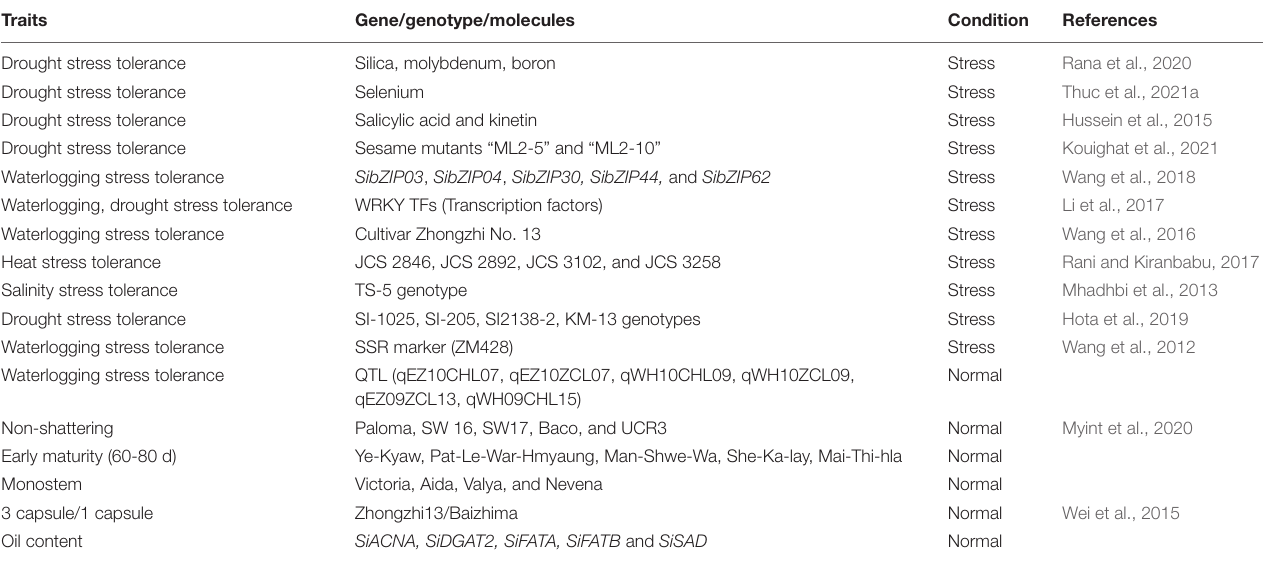
TABLE 7 | Traits related to yield enhancement in sesame under normal and stress conditions.